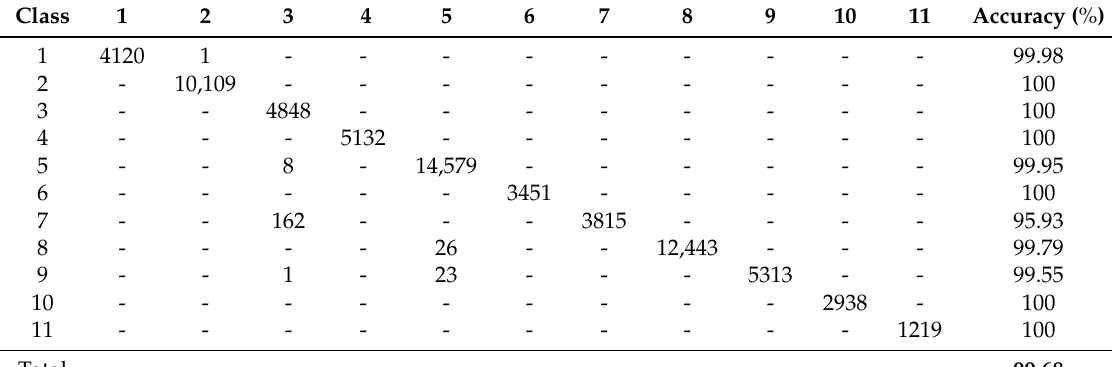
Table 5. Confusion matrix for Flevoland I data using NRS-MRF.